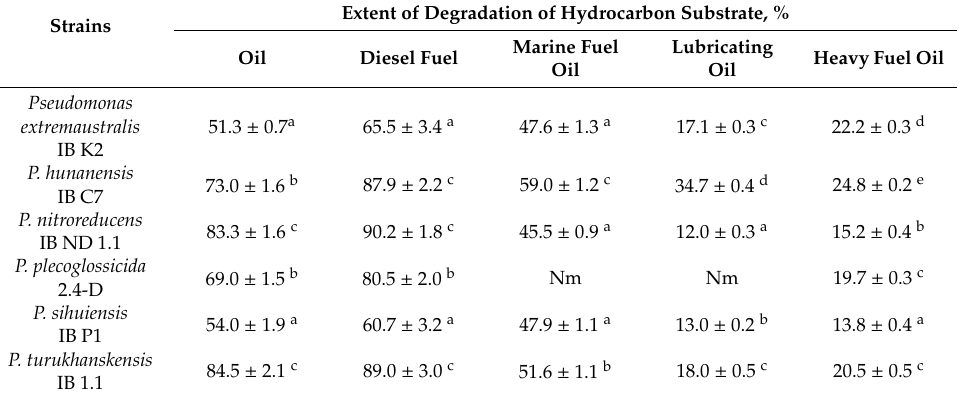
Table 2. Degradation of oil and oil products by strains of Pseudomonas after 3 days of cultivation on Raymond media containing 2 g L − 1 of hydrocarbon